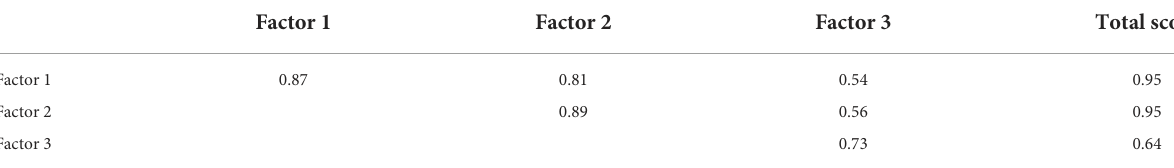
TABLE 4 The correlation coefficient between factors and factor-total score, the square root of the average variance